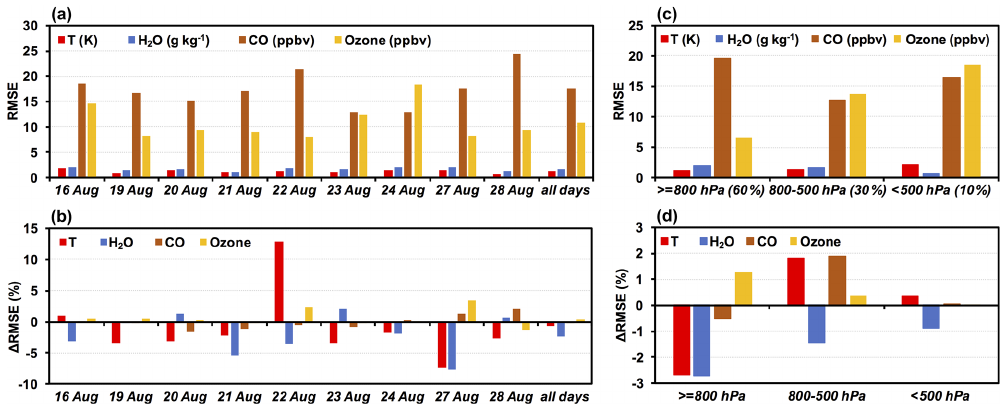
Figure 8. Evaluation of WRF-Chem results with the B-200 aircraft observations during the ACT-America 2016 campaign: (a, c) the RMSEs of air temperature ( T ), water vapor mixing ratio (H 2 O), carbon monoxide (CO), and O 3 of the model base case; and (b, d) the impacts of the SMAP DA on RMSEs of these variables. Panels (a, b) and (c, d) summarize the model performance by flight day and flight altitude range, respectively. The B-200 flight paths by day are shown in Fig. 1d. Proportions of ∼ 60%, ∼ 30%, and ∼ 10% of the related aircraft observations were taken at ≥ 800, 800–500, and < 500hPa, respectively.